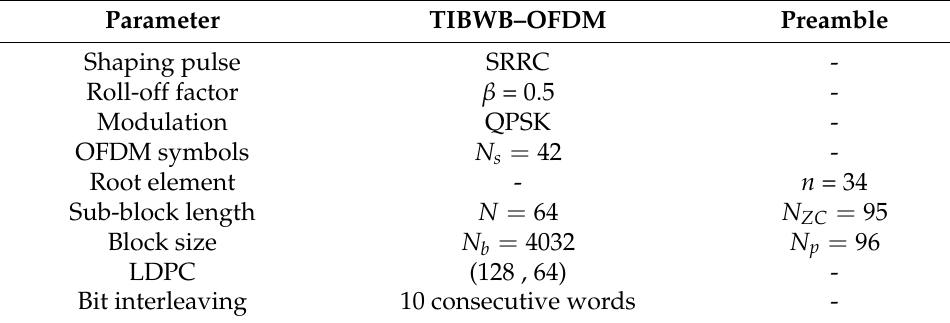
Table 1. Simulation